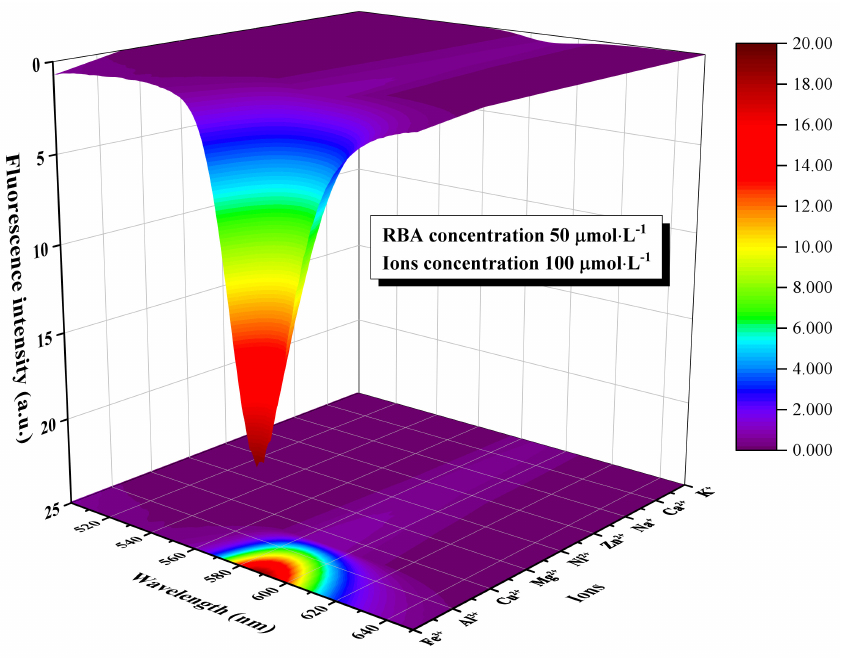
Figure 9. The integrated fluorescence intensity of RBA in different metal ions environments which were equal in concentration.